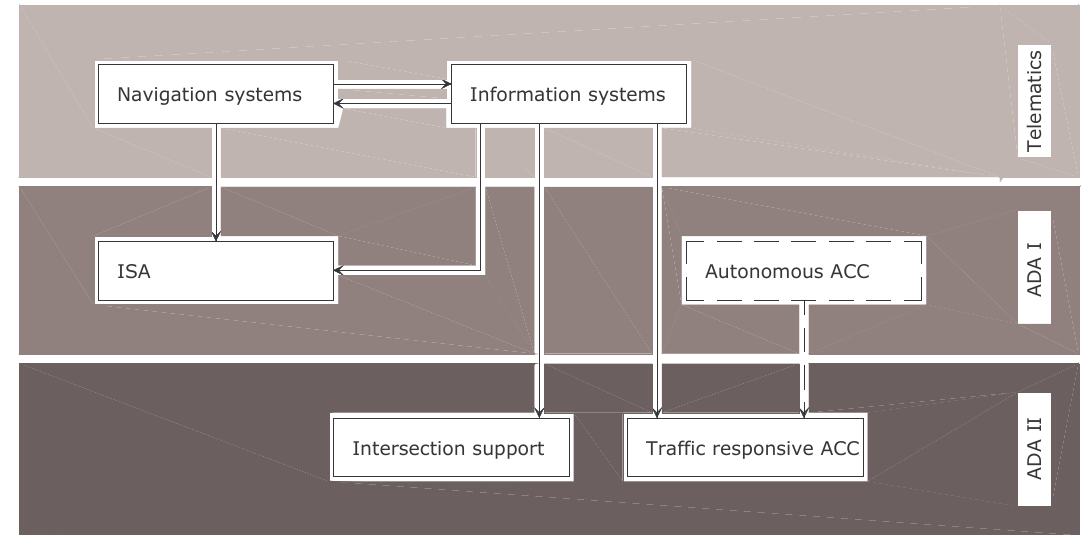
Figure 2. Relations between five potentially viable concepts for co-operative